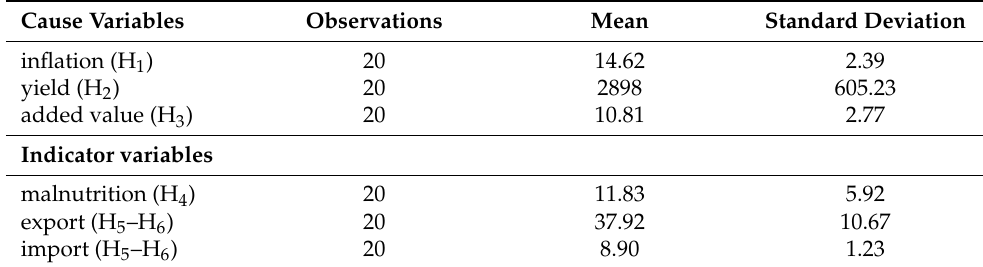
Table 1. Descriptive statistics of the variables.